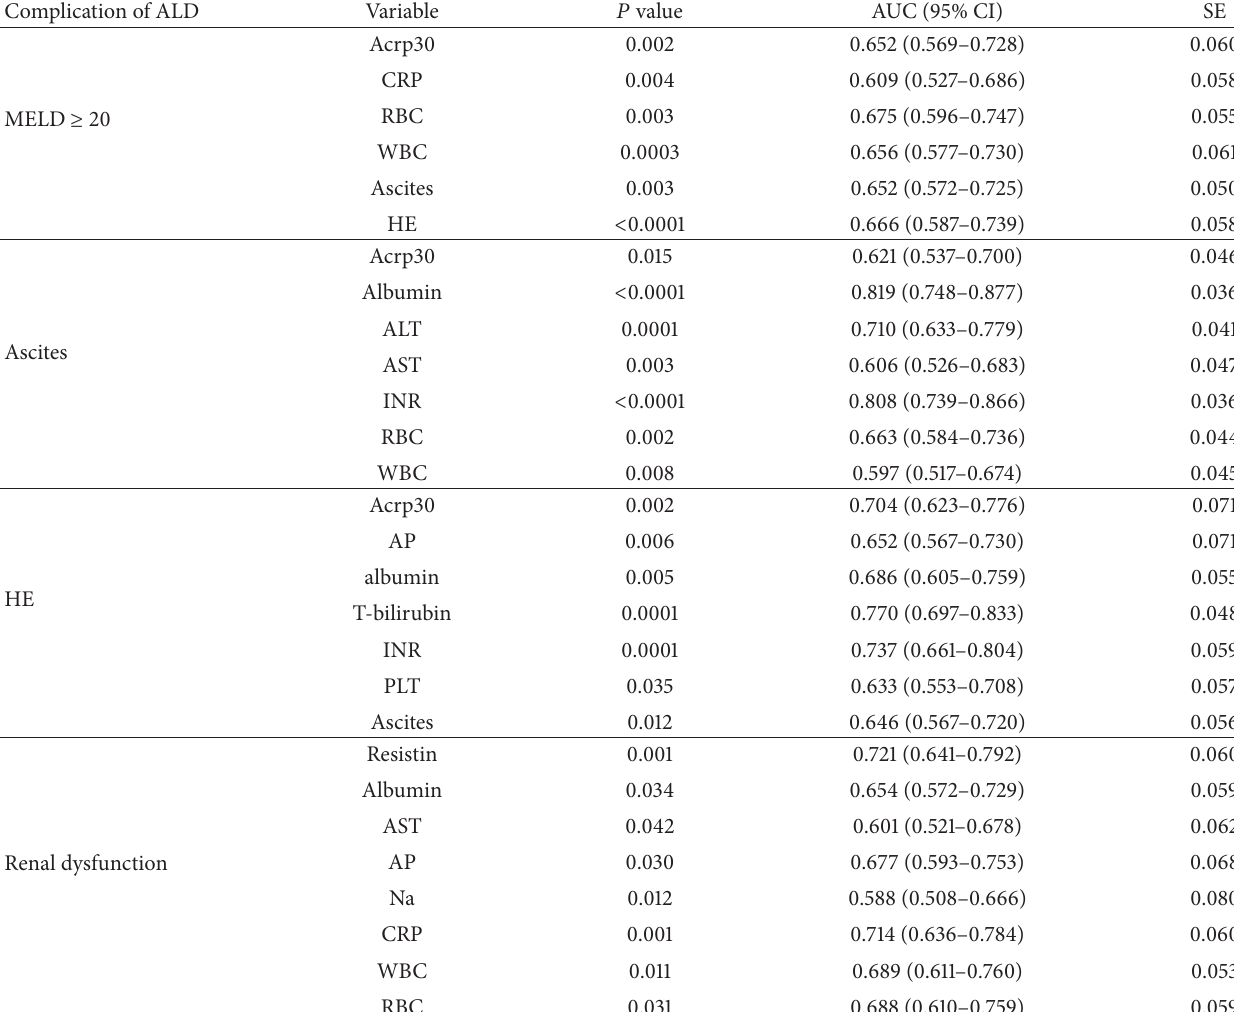
Table 11: Comparison of the diagnostic accuracy (AUCs) of single variables in the diagnosis of advanced liver dysfunction (MELD ≥ 20) and ALD complications. (univariable analysis) ∗ .